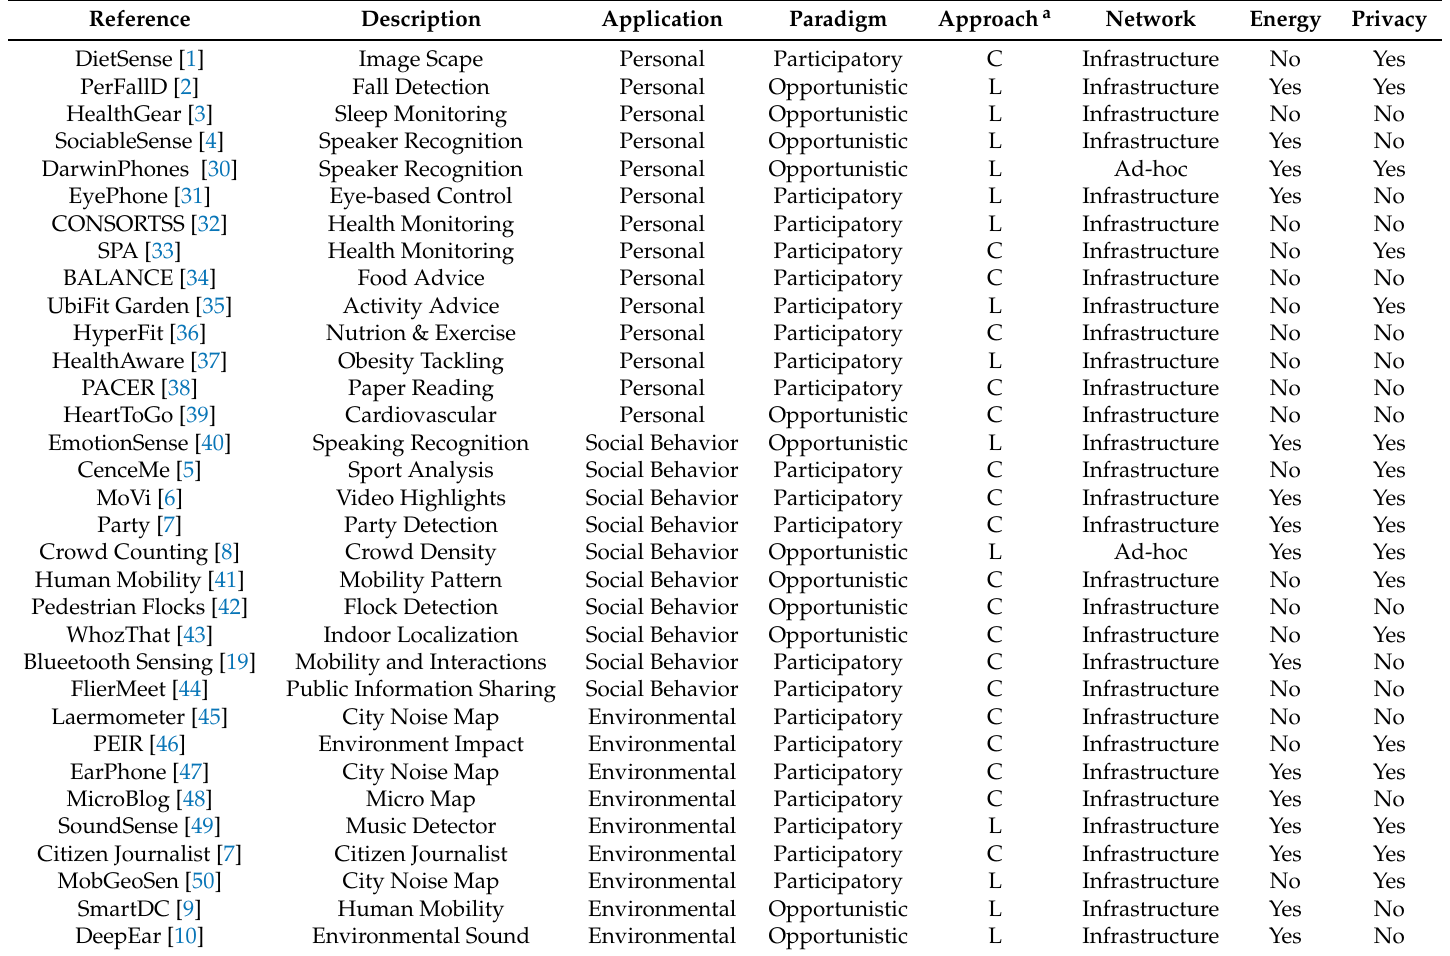
Table 1. Smartphone-based Sensing